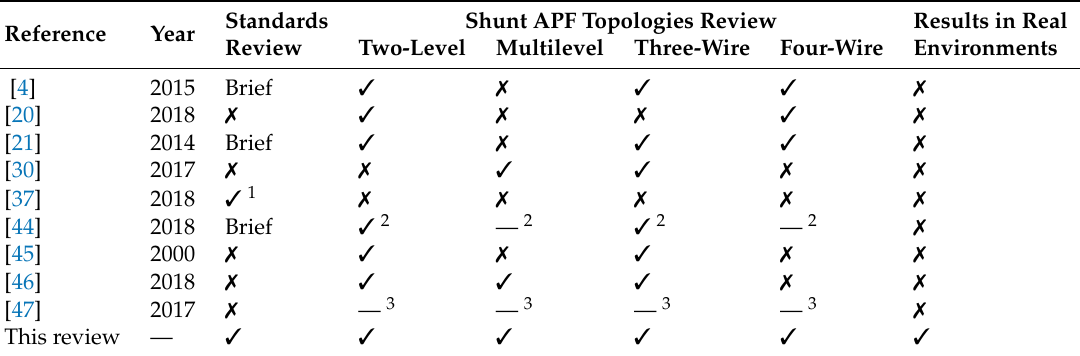
Table 2. Scope of previous power quality